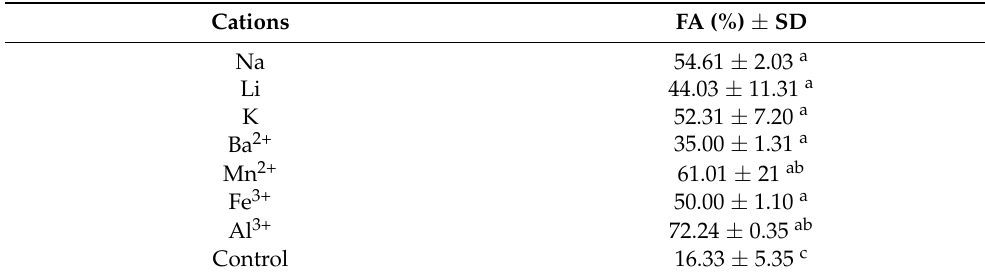
Table 4. Effect of cations on